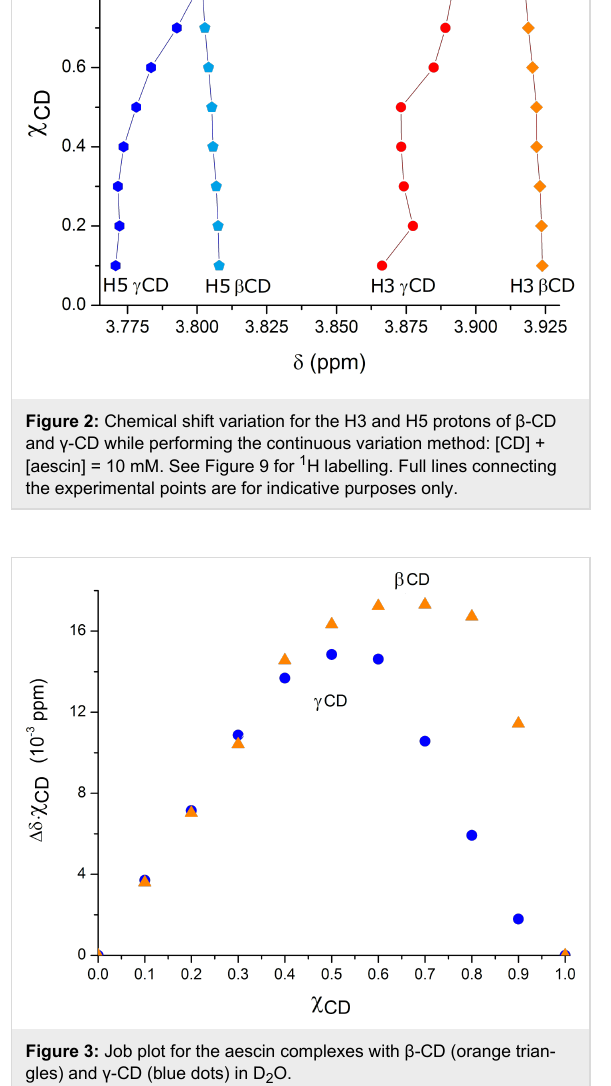
metric and the shift observed at 0.6 ( χ of γ -CD) denotes the presence of at least another specimen in solution, most likely the 2:1 γ -CD/aescin species.